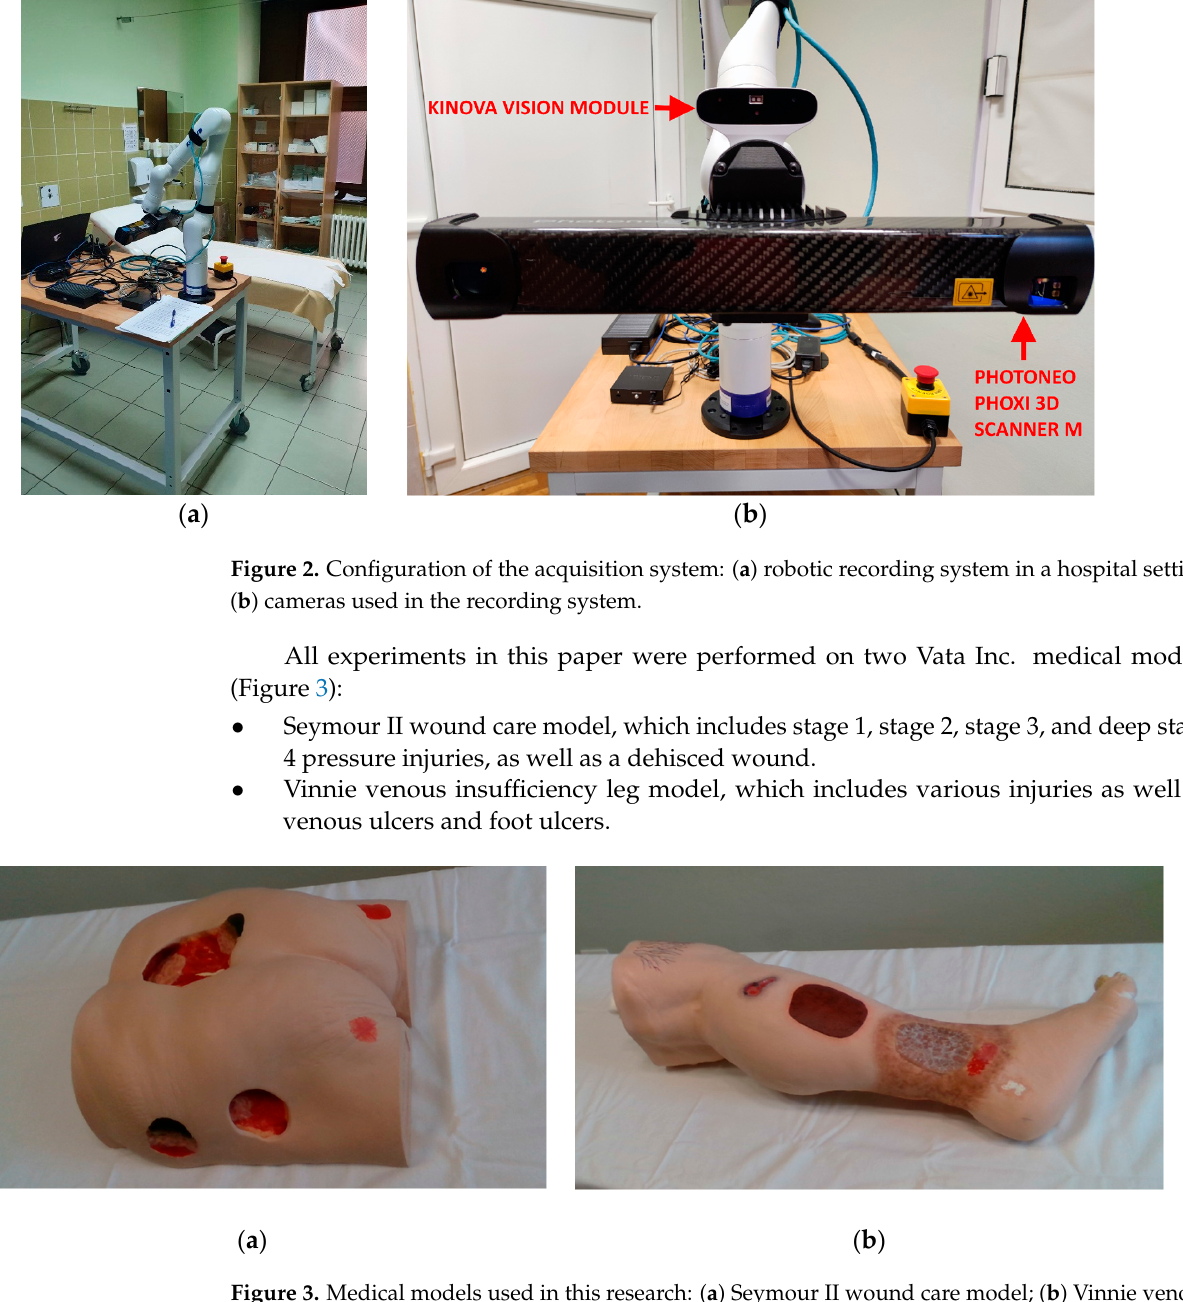
Figure 3. Medical models used in this research: ( a ) Seymour II wound care model; ( b ) Vinnie venous insufficiency leg